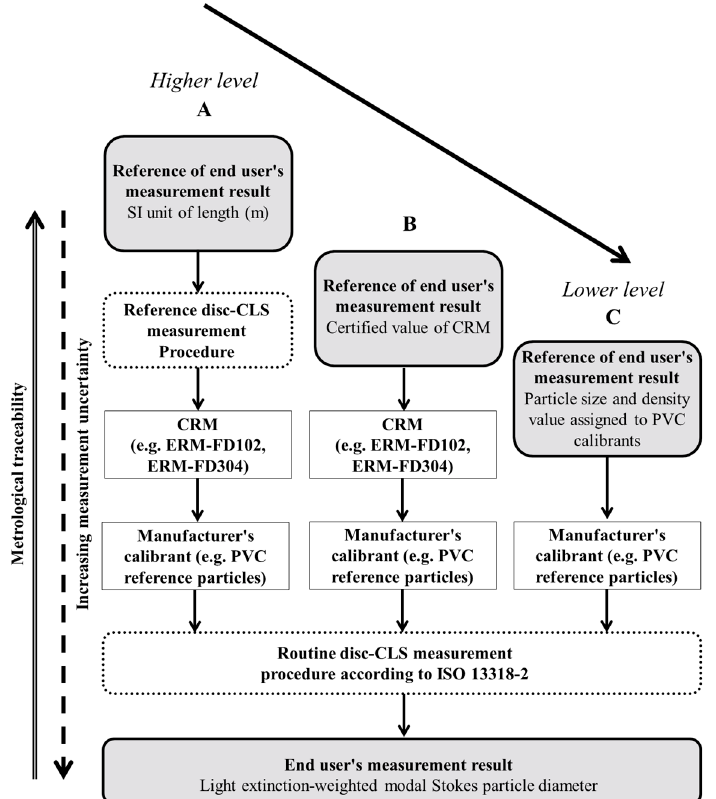
Figure 3. A simplified representation of different traceability chains, each providing a different level of traceability.